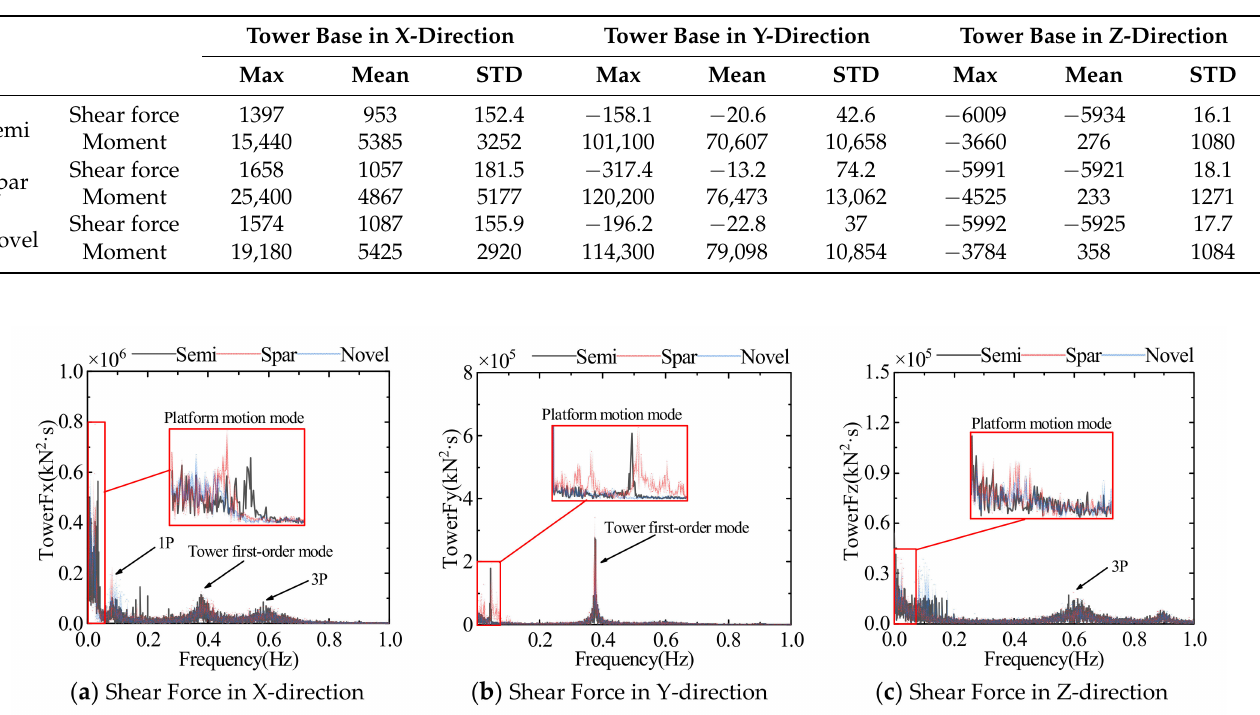
Table 13. The statistics of loads at tower base.